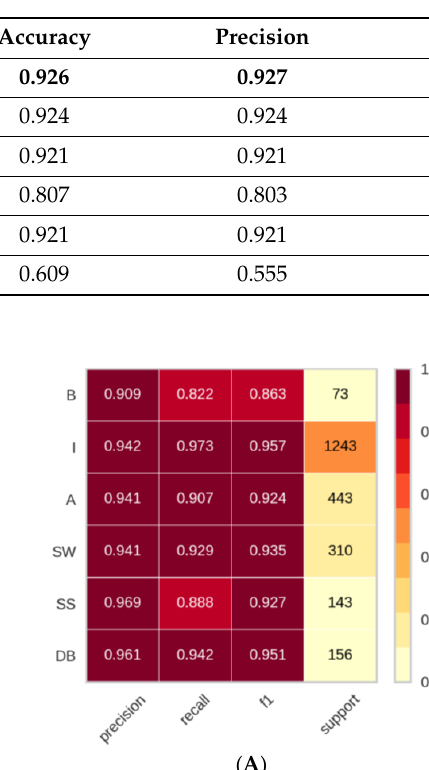
Table 9. Machine-learning model performances on the test set for six-class classification using the top four important features. The best performances are highlighted in bold.